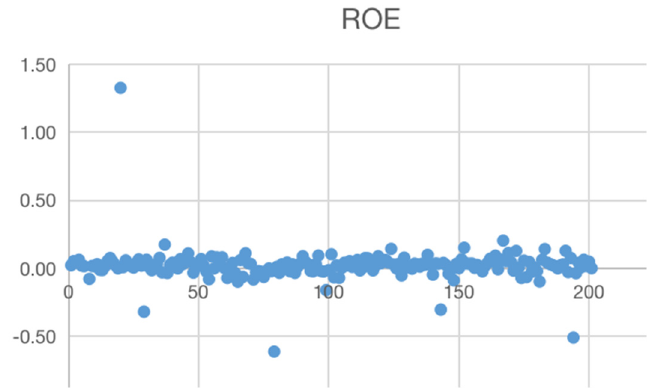
Figure 2. Distribution of main business profits.